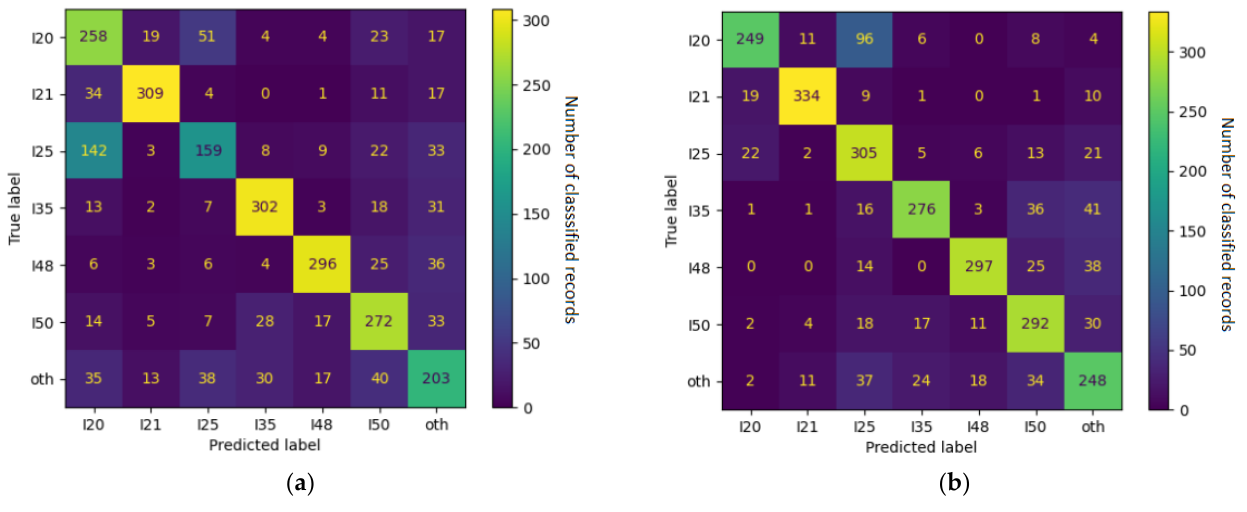
Figure 4. Confusion matrices for the 6 + 1 models trained on ( a ) admission data and ( b ) discharge